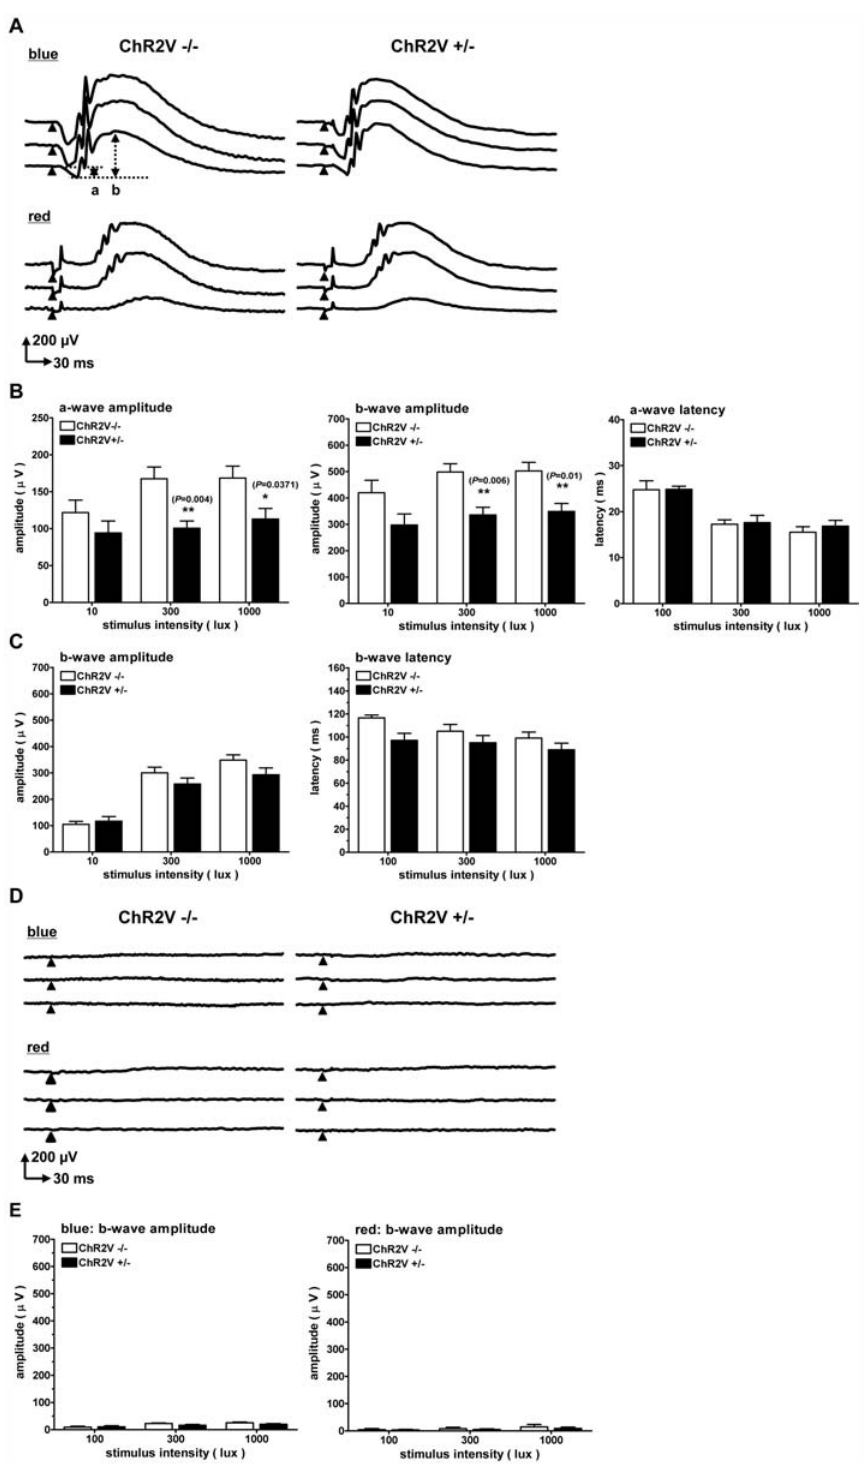
Figure 5. Electrophysiological evidence of photoreceptor degeneration. (A) Typical waveforms of electroretinogram (ERG) responses evoked by either blue or red light-emitting diode (LED) flash (duration: 10 ms; light intensity: 1000, 300, and 100 lux, top to bottom). (B)The ERG amplitudes (left, a-wave; middle, b-wave) and the latency of the a-wave (right) in response to the blue LED flash. Note that both amplitudes were significantly diminished in the ChR2V + / 2 rats compared to the ChR2V 2 / 2 rats without any differences in a-wave latency. (C) The b-wave amplitudes (left) and the latency (right) in response to the red LED flash. (D)Typical ERG waveforms evoked by either blue (upper traces) or red (lower traces) LED flash in the ChR2V 2 / 2 (left) and + / 2 (right) rats after continuous light (3000 lux) exposure for 7 days. (E)The b-wave amplitudes recorded from the rats after continuous light exposure. Error bars represent standard deviation (n=8, **: P , 0.01, unpaired t-test).